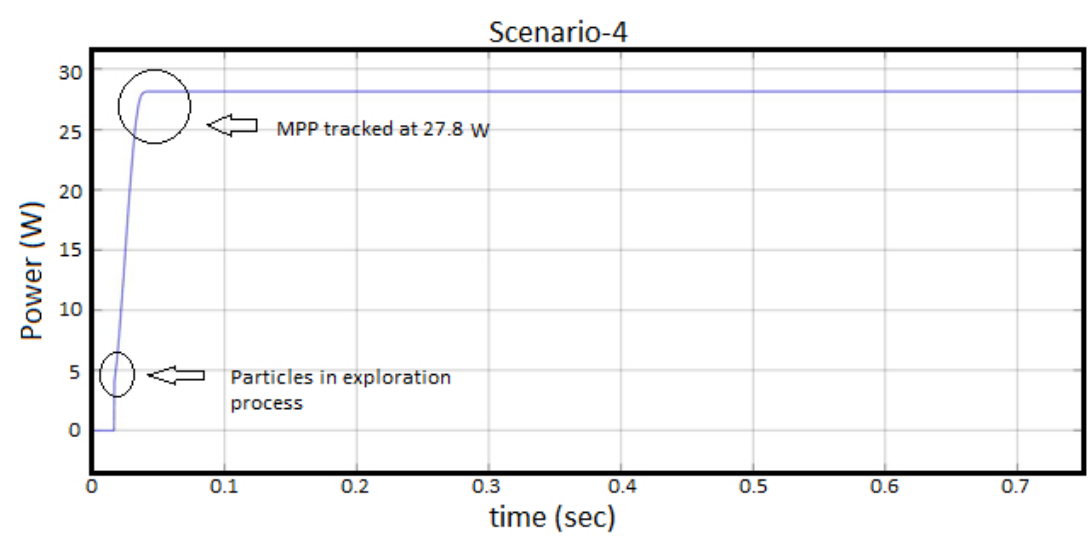
Figure 9. Performance of ICPSO under